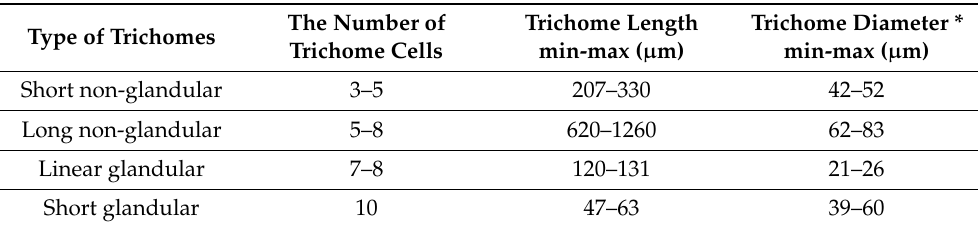
Table 3. Characteristics of Ambrosia artemisiifolia trichomes present on the perianth and bracts of staminate